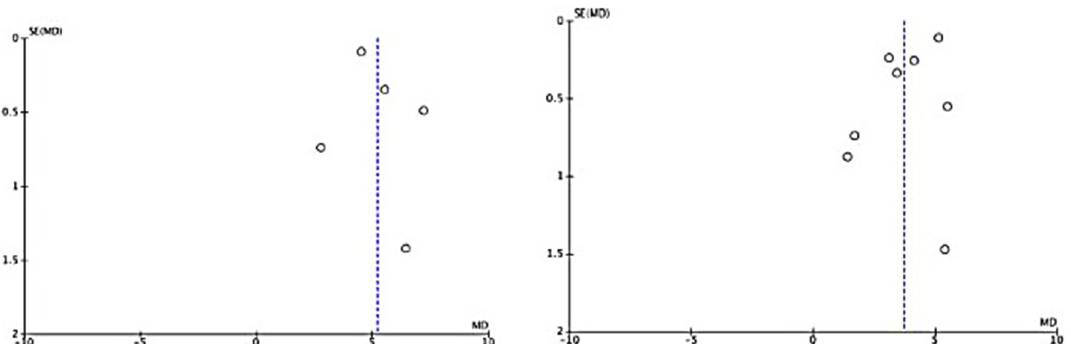
Figure 10. Funnel plot presenting publication bias and heterogeneity analyzes of pre- and post- intervention of ICBT for depression patients ( left ) and anxiety patients ( right ) during COVID-19 pandemic calculated in meta-analysis. The small circle represent individual study.